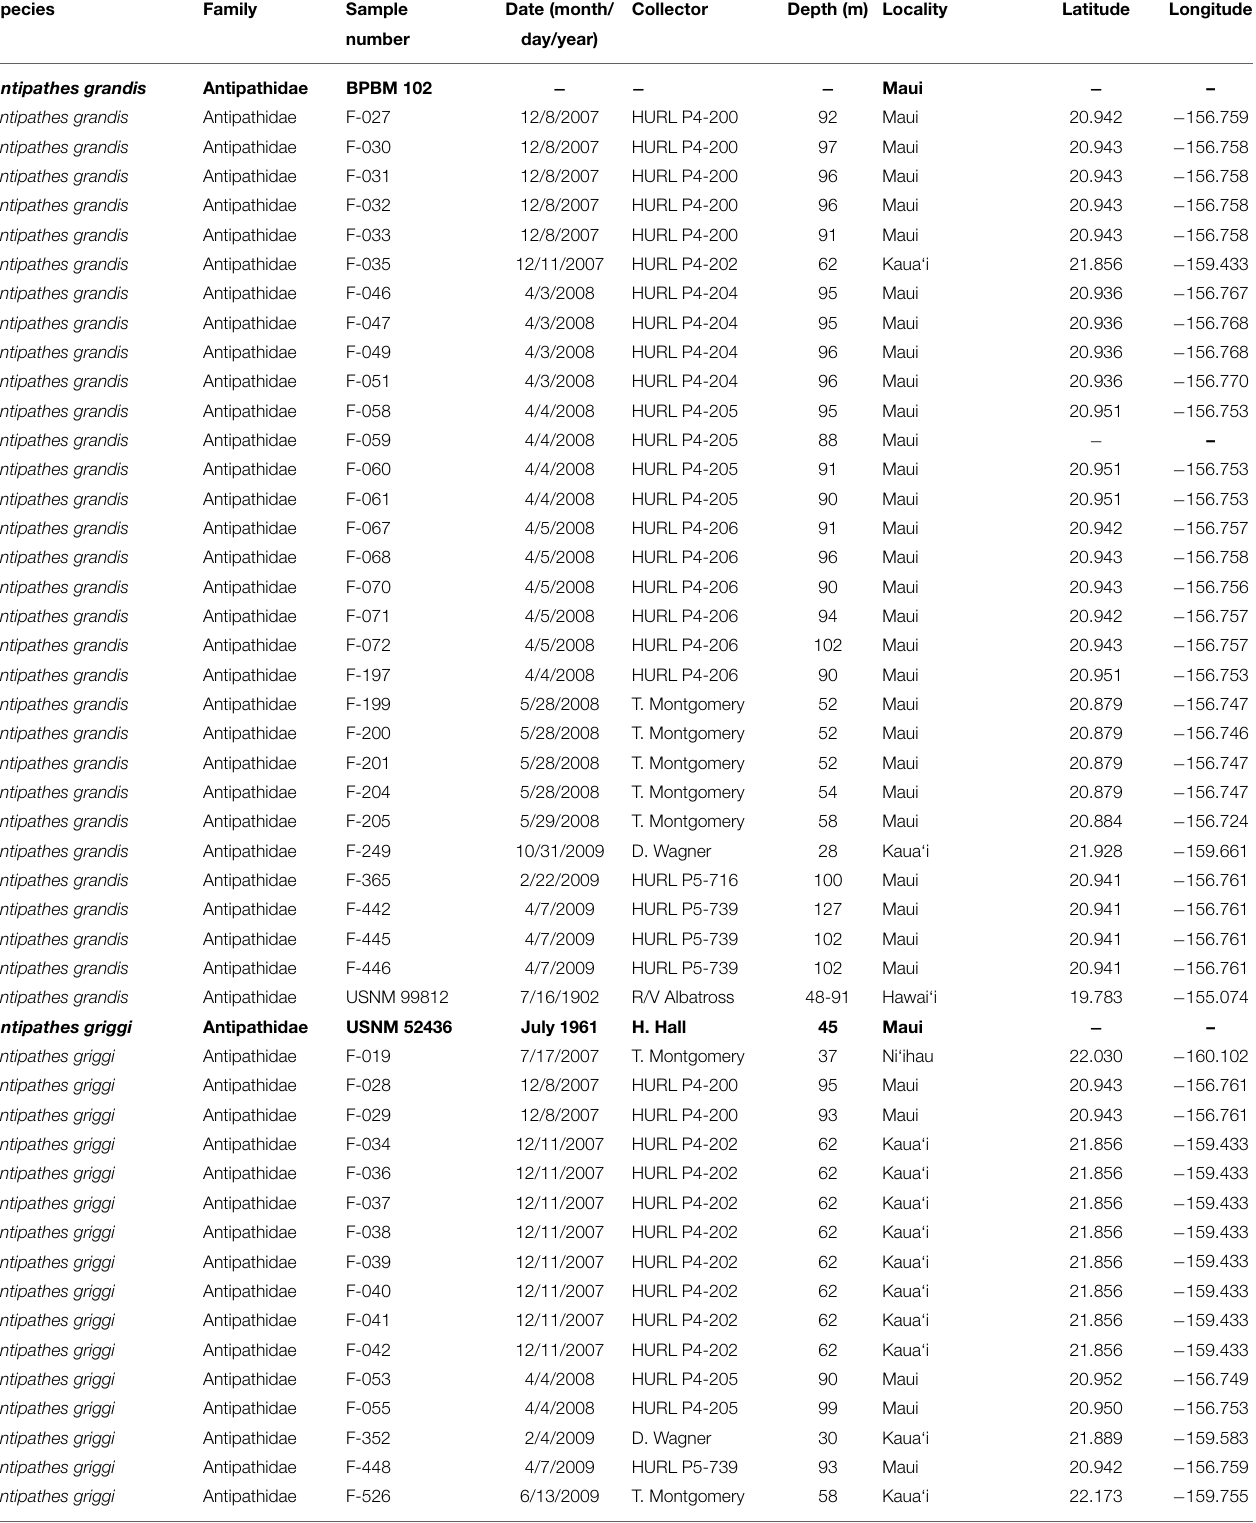
TABLE 1 | Antipatharian samples examined as part of this study.